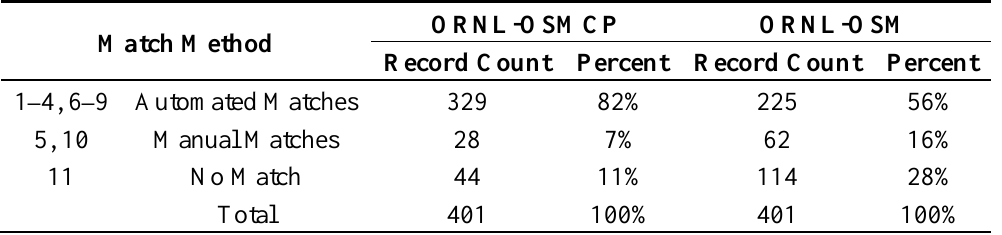
Table 3. Matching results for ORNL and